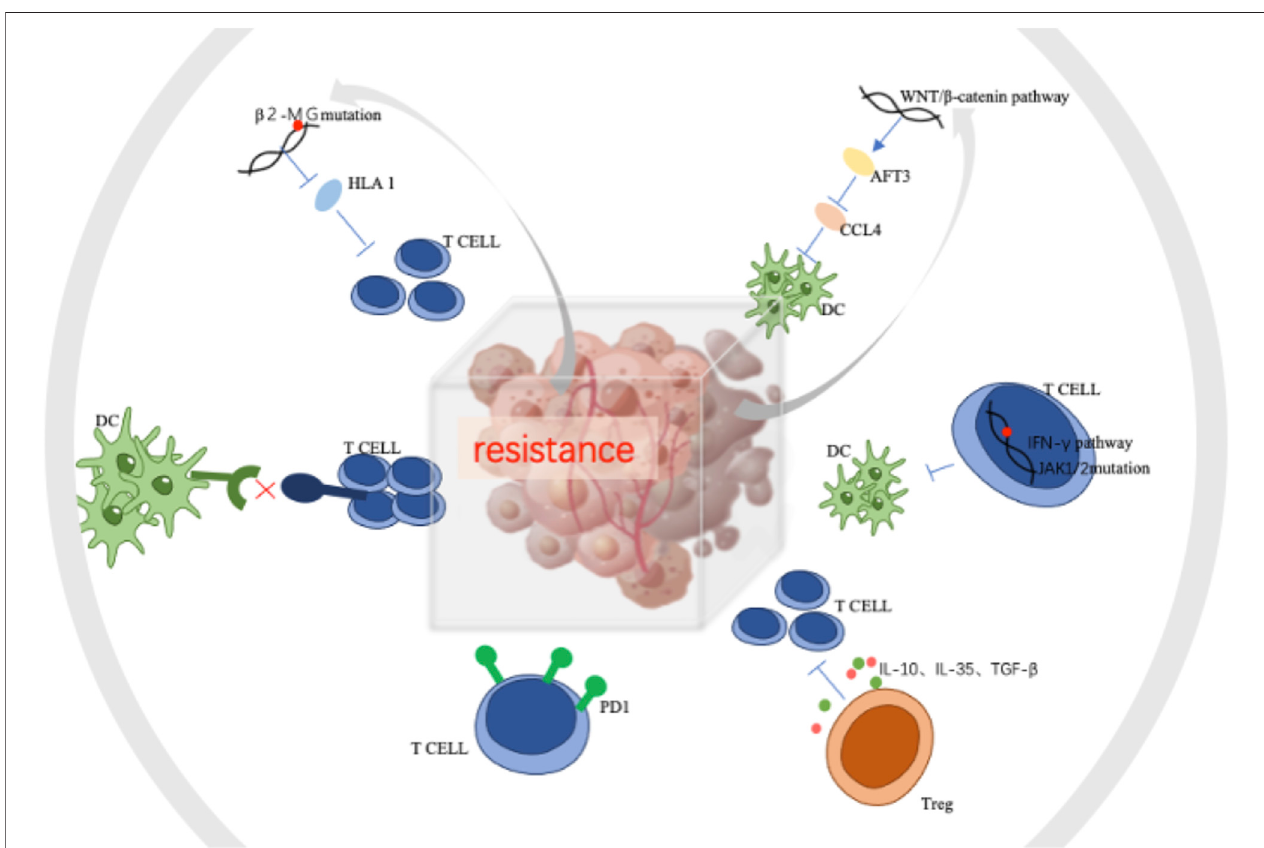
FIGURE 3 | The mechanism of